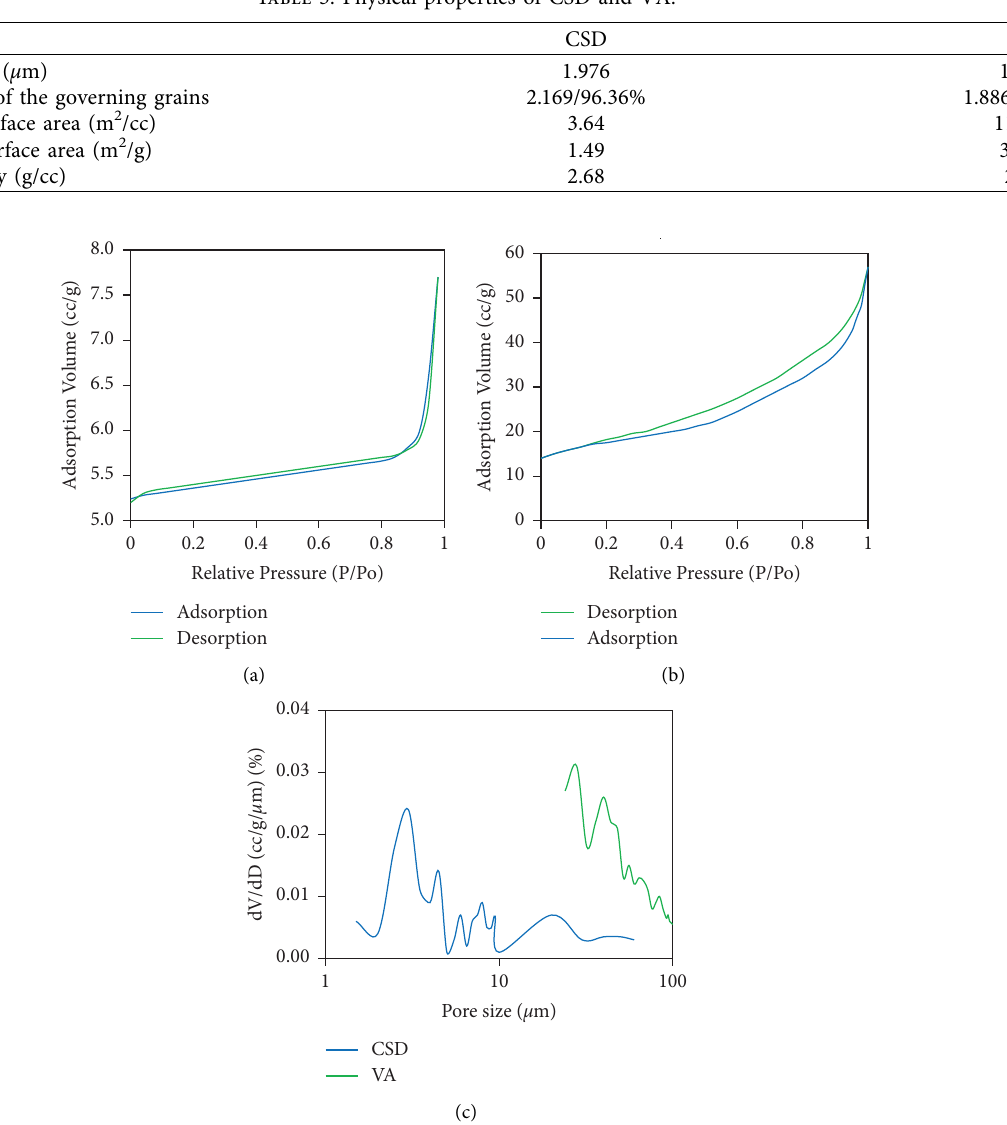
Figure 2: N adsorption isotherm of (a) CSD and (b) VA and (c) their pore